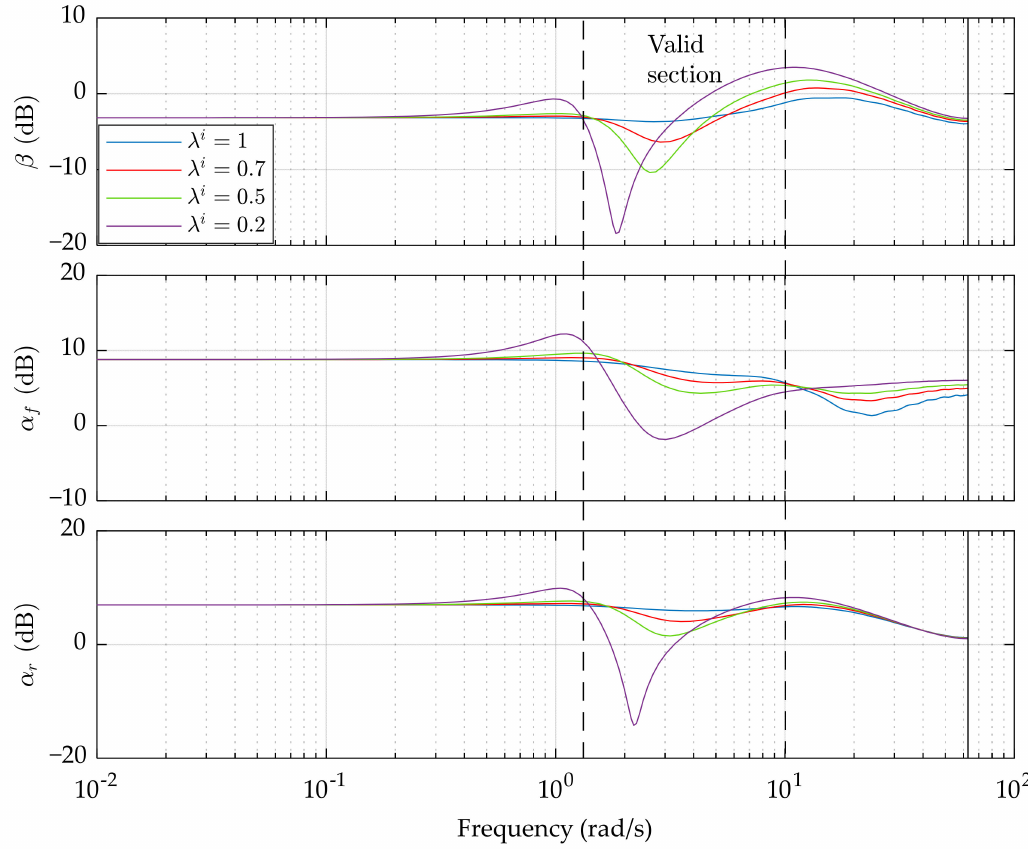
Figure 3. Constrained variables performance in the frequency domain. Only the magnitude is presented. The vehicle speed is 20 m/s and the preview length is set to